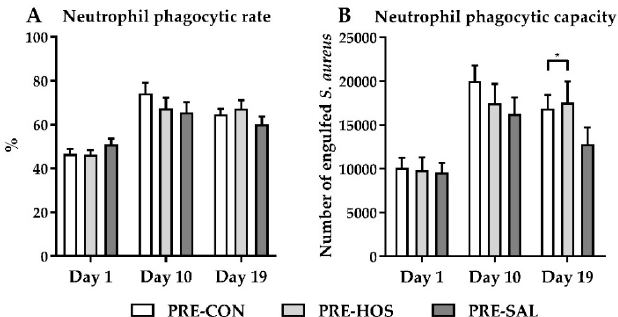
Figure 5. Phagocytic activity in preterm pigs (Experiment 1). ( A ) Proportion of neutrophils exerting phagocytosis against Staphylococcus aureus and ( B ) total number of engulfed S. aureus by neutrophils. Values are presented as mean ± SEM. The * indicate statistical significant difference between groups of p < Table 1. Serum and CSF biochemistry measured at day 19 in preterm pigs (Experiment 1).